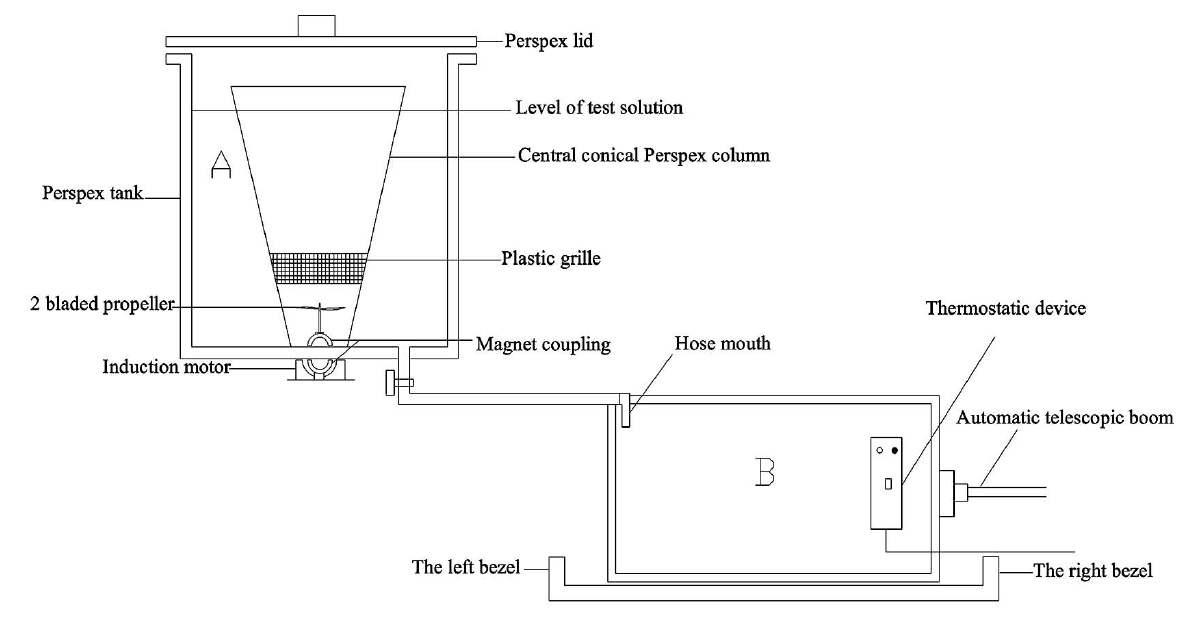
Fig. 1. – Experimental